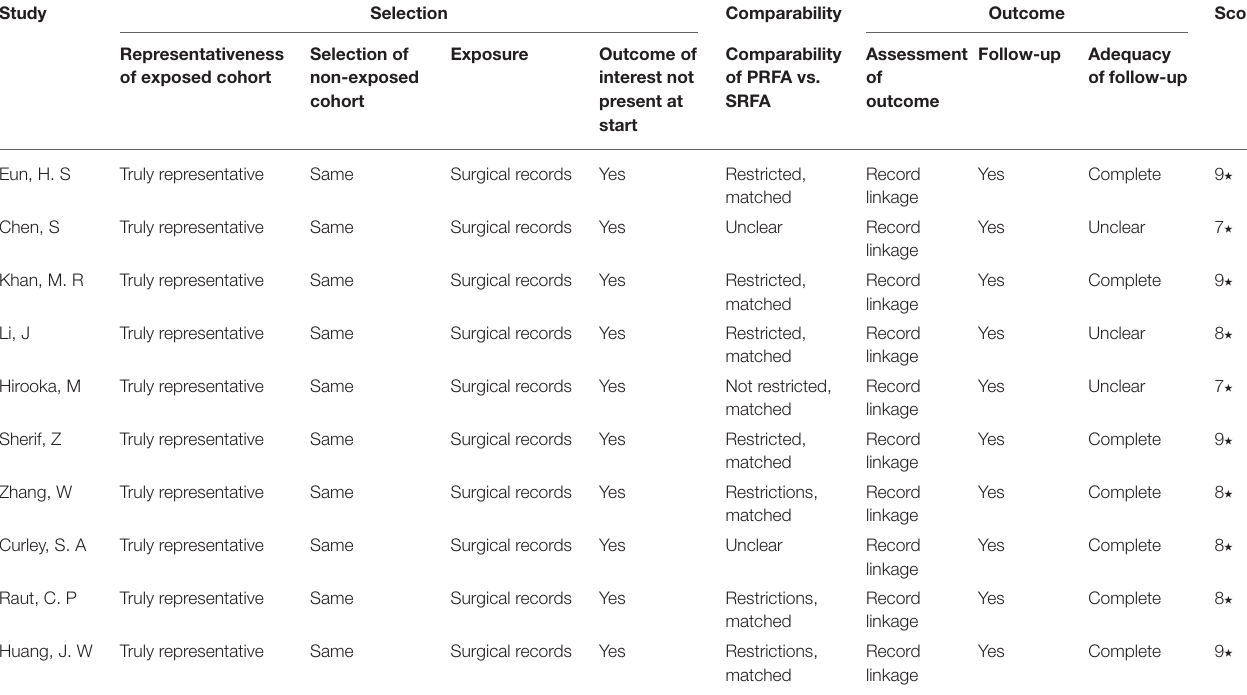
TABLE 2 | Risk of bias using the modified Newcastle-Ottawa Scale. Study